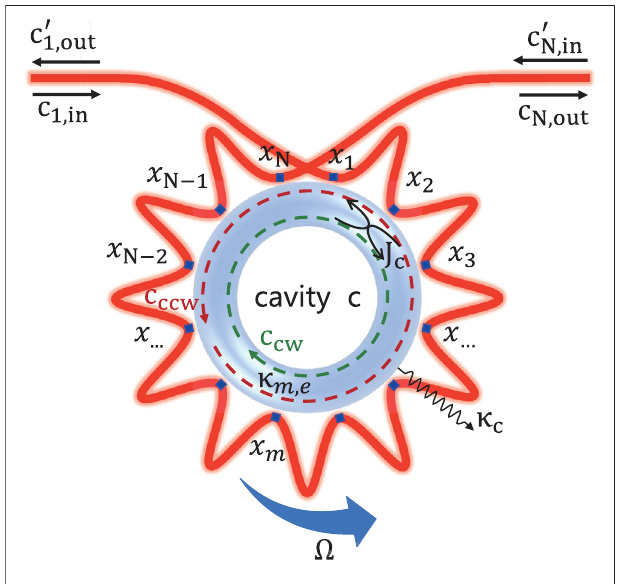
FIGURE 1 | (Color online) Schematic of a spinning resonator coupled to a meandering waveguide at multiple coupling points x m with the external loss rate κ m , e . The resonator rotates along the CCW direction with an angular speed Ω . The CW and CCW modes of the resonator couple to each other with strength J . The intrinsic decay rate of the resonator is κ c